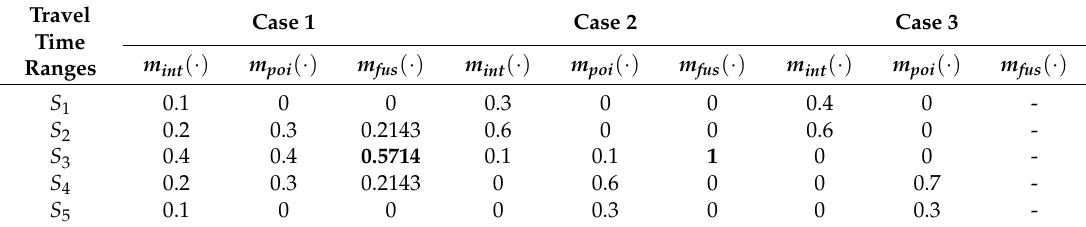
Table 1. Simple example of distribution fusion using Dempster’s combination rule.